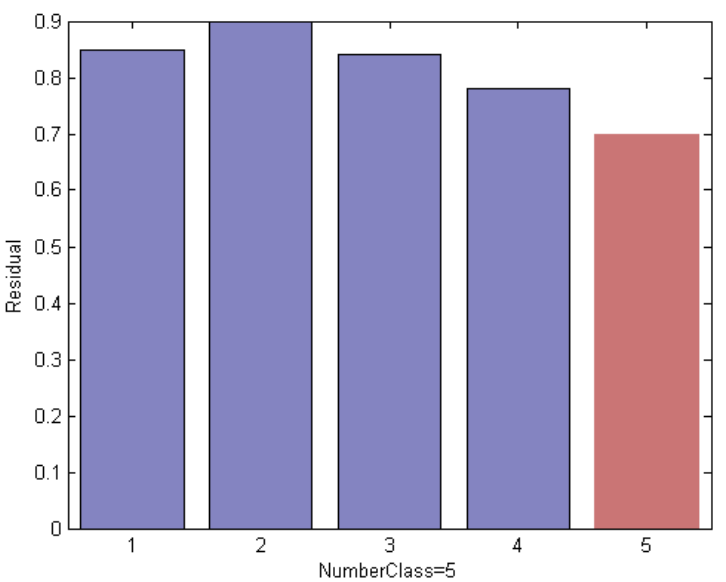
Figure 9. Reconstruction error of a test image using the original ORL subset, which leads to incorrect classification